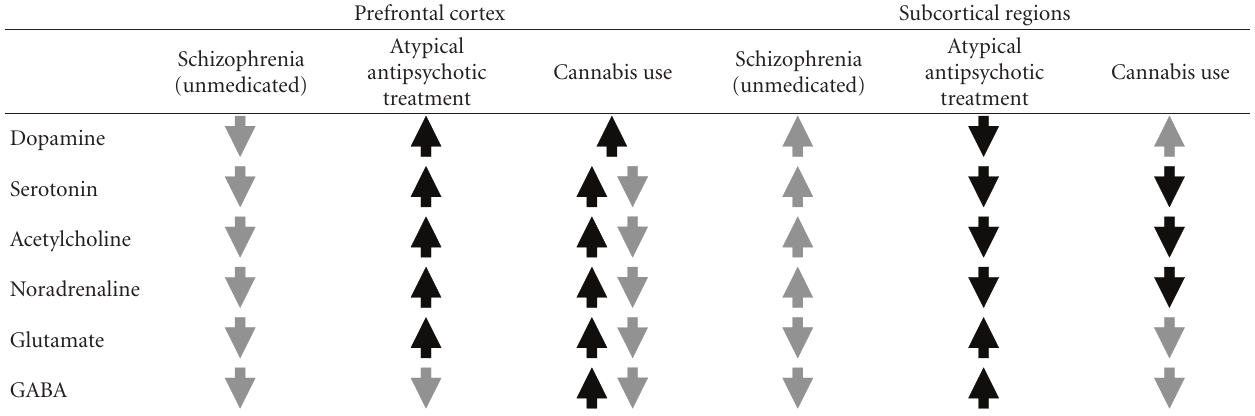
Table 1: Directions of neurotransmitter release in the prefrontal cortex and subcortical